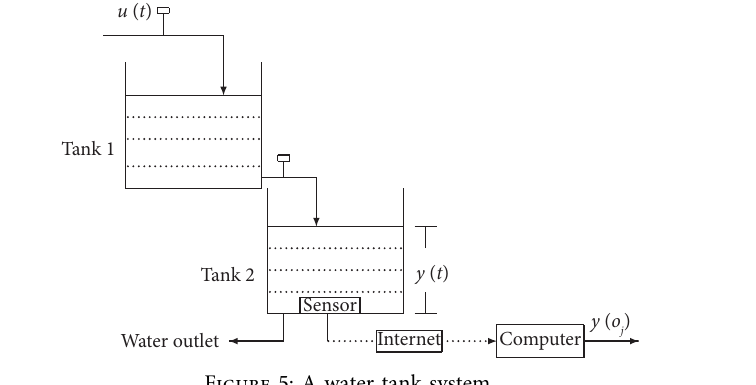
Figure 5: A water tank system.